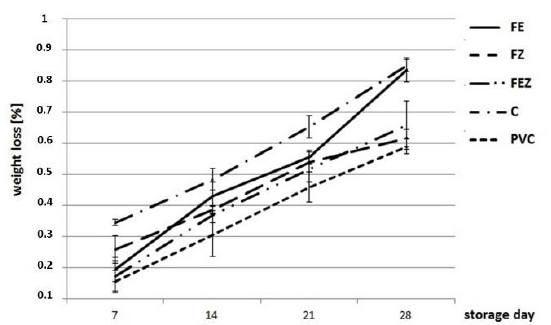
Figure 2. Weight loss of white button mushrooms packed in different active packages containing zeolite (FZ), aҫai extract (FE), aҫai extract + zeolite (FEZ) packed in MAP, without active packaging in MAP (C) or wrapped in polyvinyl chloride foil (PVC) measured on each storage day. Standard error is presented in a form of horizontal bars.